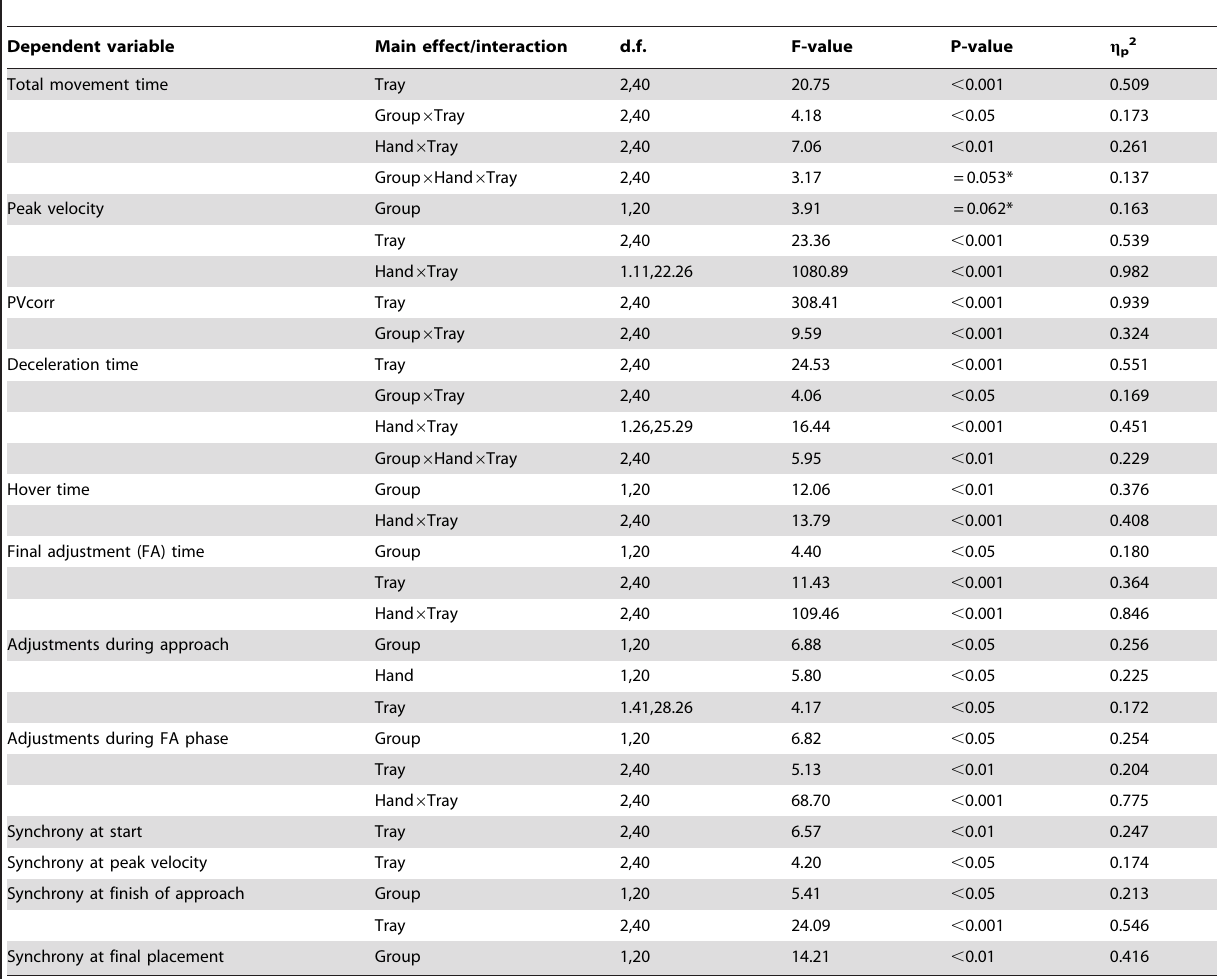
Table 2. The significant main effects and interactions; effect size is reported as partial eta